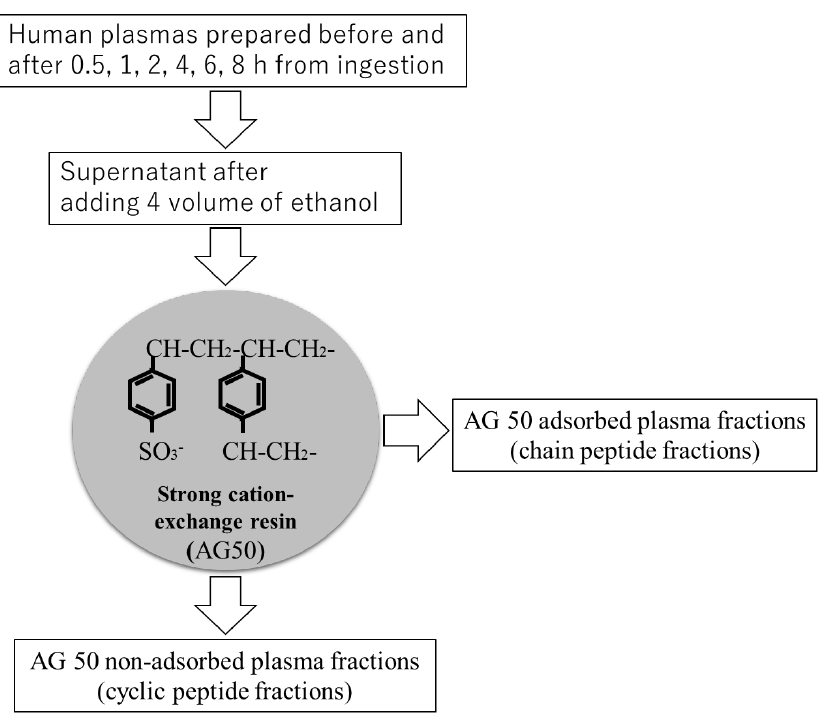
Figure 3. Diagram of the separation procedure for cyclic and linear peptide fractions from human plasma before and after ingestion of collagen